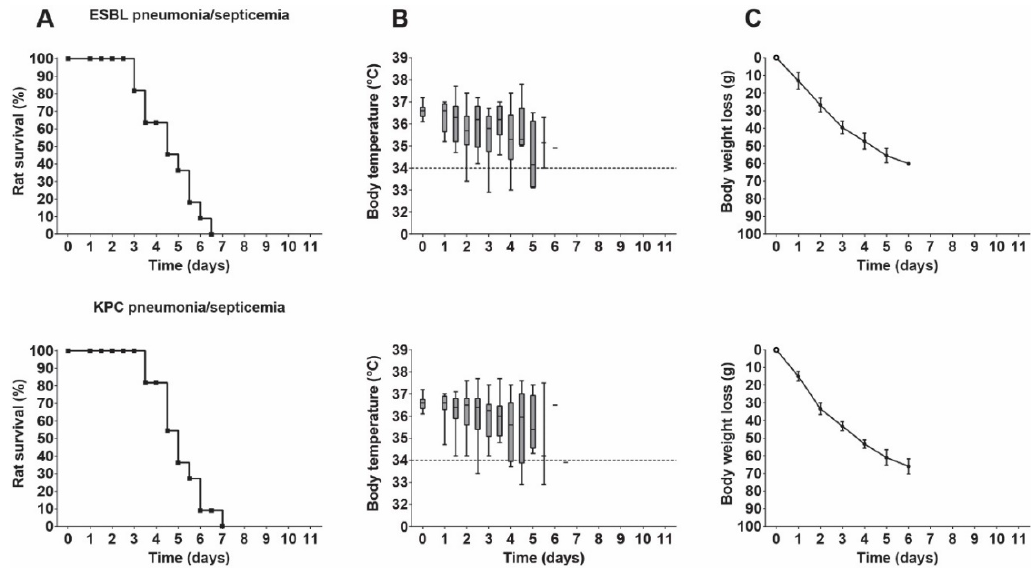
Figure 3. Disease progression in rats with K. pneumoniae pneumonia–septicemia. Groups of 11 rats were used for each experiment. ( A ) Rat survival (Kaplan–Meier curves) of rats reaching humane endpoints. ( B ) Box plots of pooled body temperatures showing the range of the data; the dashed line at 34 °C represents the humane endpoint. ( C ) Body weight loss from the onset of the infection (mean ± SD).